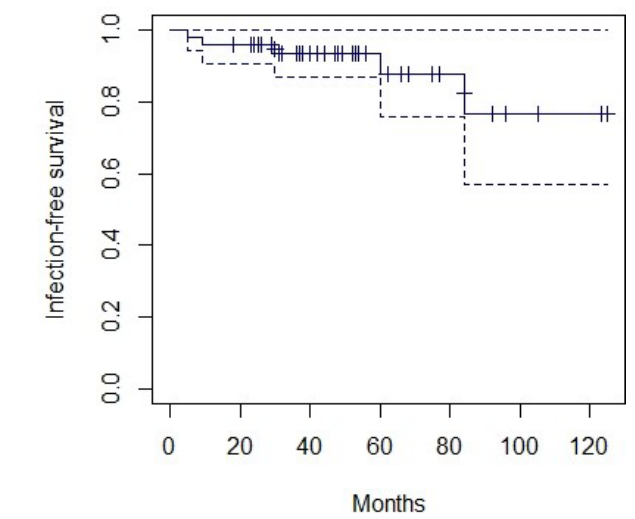
Figure 2. Infection-free survival Kaplan–Meier curve with 95% confidence interval (dotted